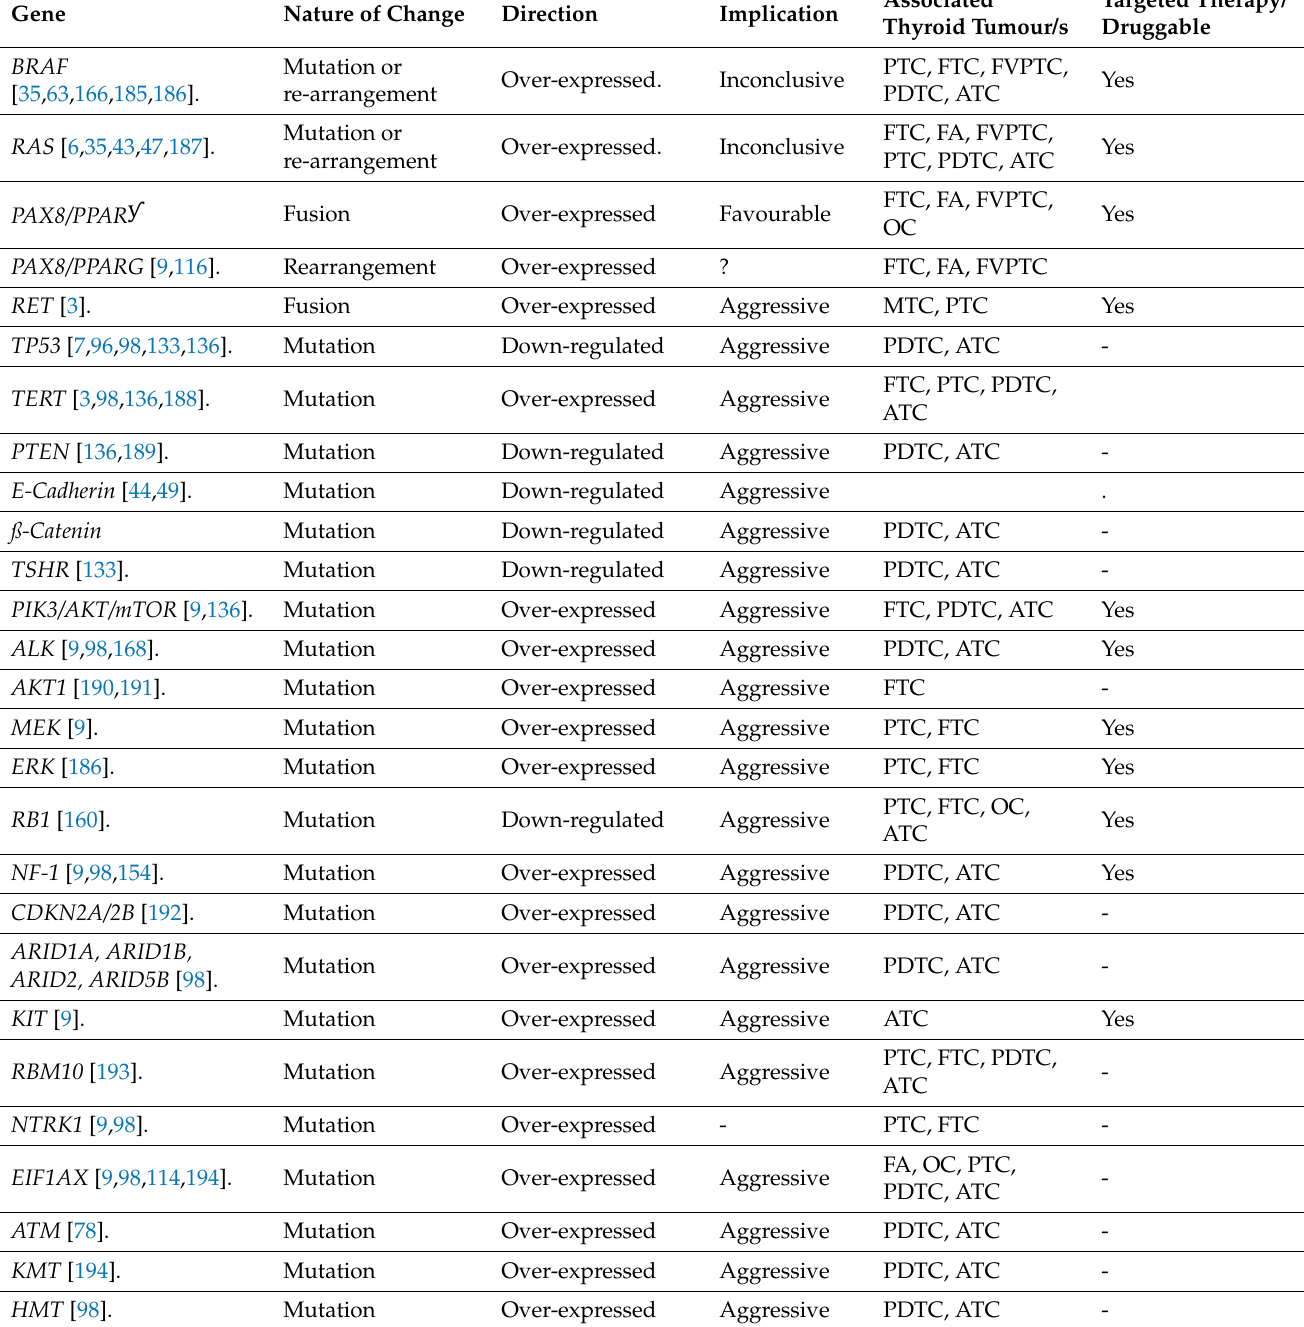
Table 1. Comparison of demography and clinicopathological features of follicular and papillary carcinomas. Table 2. Lists of reported mutations, histone modifications, and overexpressed non-coding RNA in follicular carcinoma of the thyroid.